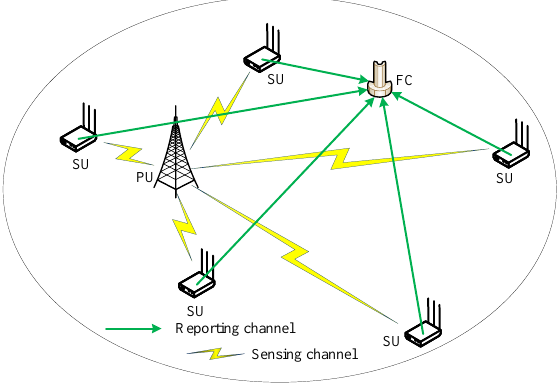
Figure 1. Basic multiple-antenna CSS